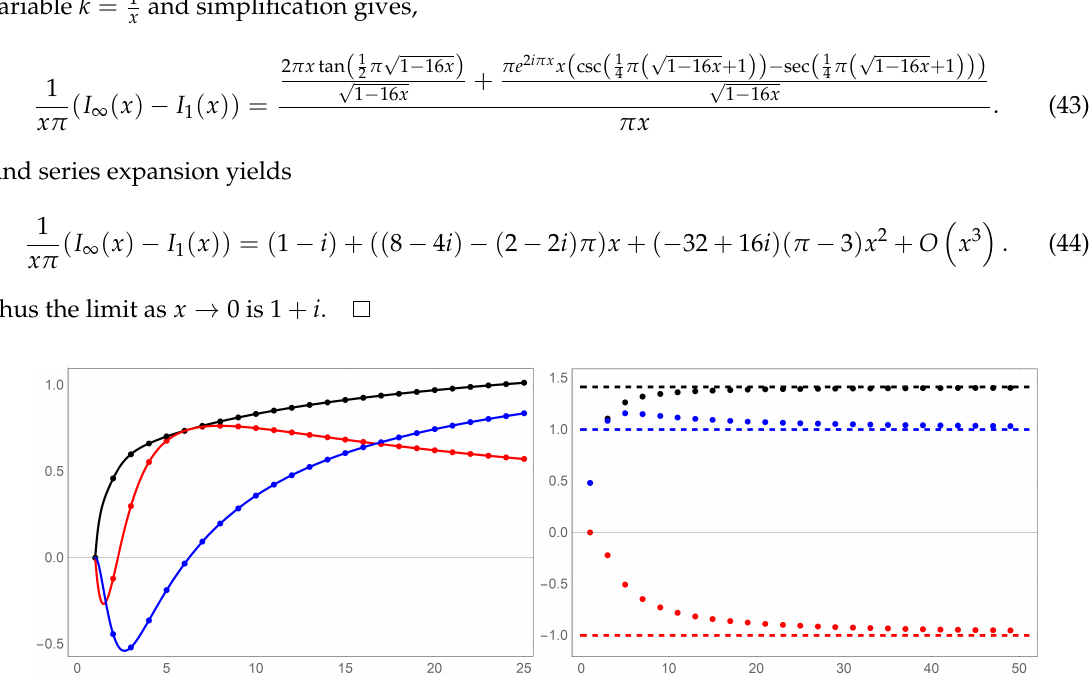
Figure 10. Left Panel: L p 1 versus p (dots: | L p 1 | - black, Re [ L p 1 ] - blue, Im [ L p 1 ] - red) for the case of k = 1. The curves arise from Equation (30) in Corollary 2. Right Panel: k L ∞ 1 ] - blue, Im [ k L ∞ 1 ] - red). The dashed lines represent the lim k → ∞ k Re [ k π π